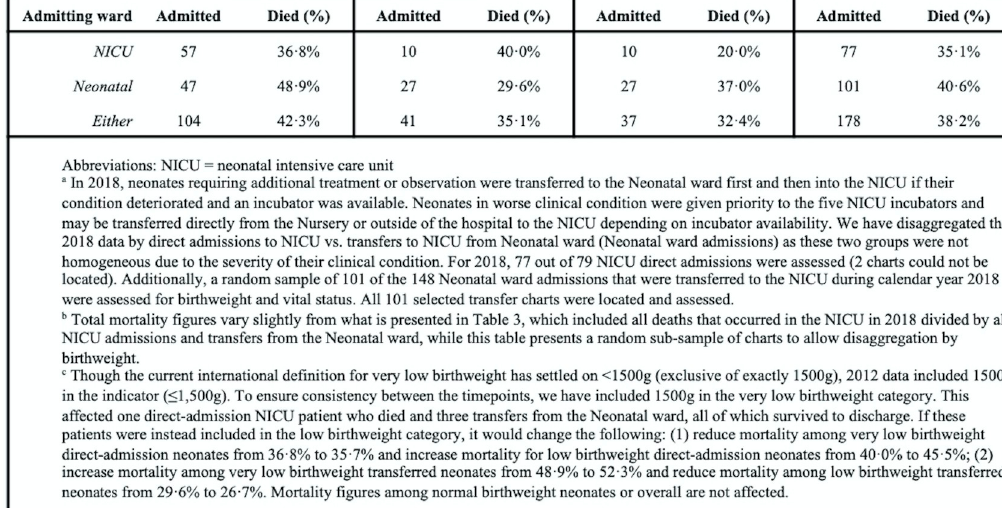
Fig 1. Neonatal intensive care unit (NICU) deaths by birthweight and admitting ward in